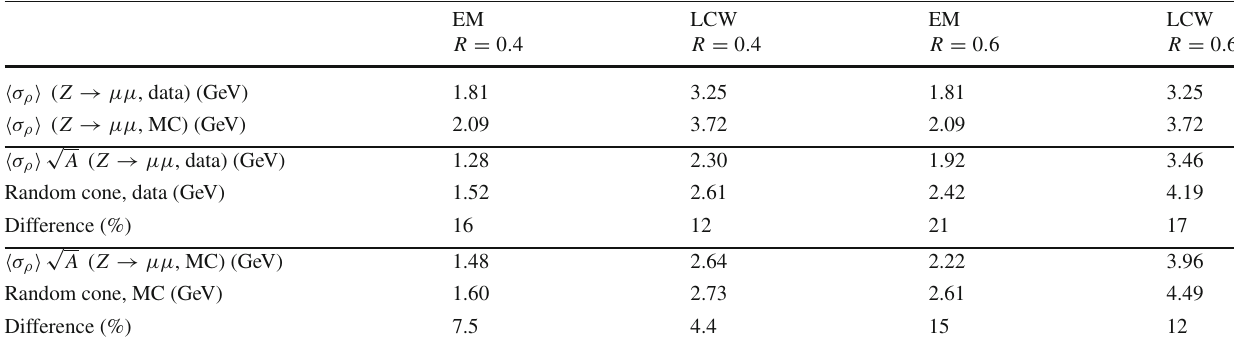
Fig. 53 Extracted values of σ ρ in data (points) and MC simulations (histogram) for a sample of Z → μμ events at the EM scale (left) and the LCW scale (right). This observable quantifies the fluctuations of the p T density ρ , i.e. the p T per area in ( y ,φ) -space (cid:9)√ Table 4 Measurements of (cid:8) σ ρ (cid:9) and (cid:8) σ ρ A , where (cid:8) σ ρ (cid:9) is the mean ment from the soft jet momentum method, is extracted using the region | η | < 2 . 1 while the noise term measurement using the random cone of the σ ρ distribution, and the random cone results, both using data and MC simulations. The area is defined by A = π R 2 , where R is the method is extracted for jet | η | < 0 . 8. Statistical uncertainties of both √ A results, which is a noise term measure- radius parameter. The σ ρ measurements are